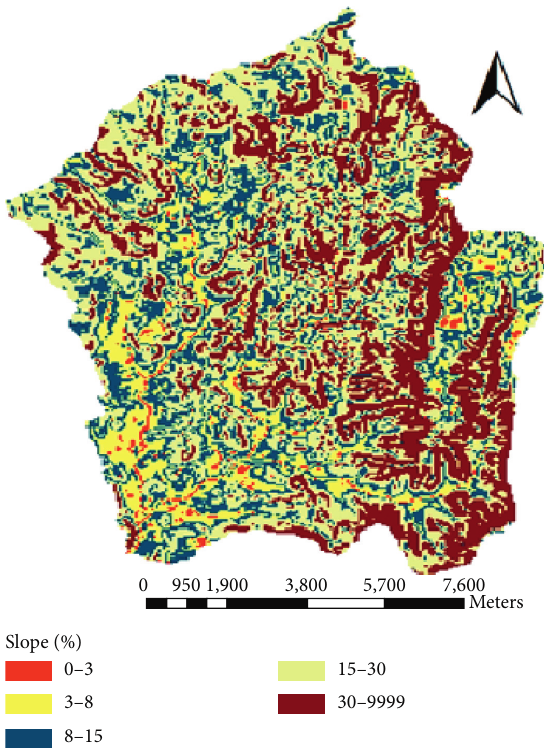
Figure 5: Elevation map of the watershed. Figure 6: Slope classes of Megech dam watershed. Table 2: Slope class of Megech dam watershed (FAO, 2002).